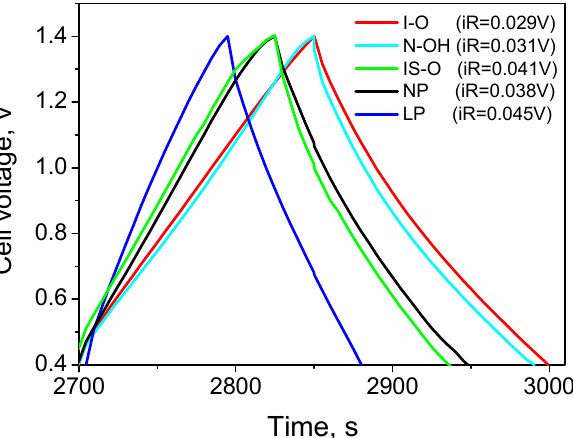
Figure 4. Galvanostatic charge–discharge curves of supercapacitor cells with different composite electrodes at a current load of 240 mA g − 1 . The drop in voltage ∆ V (i.e., iR) is shown.